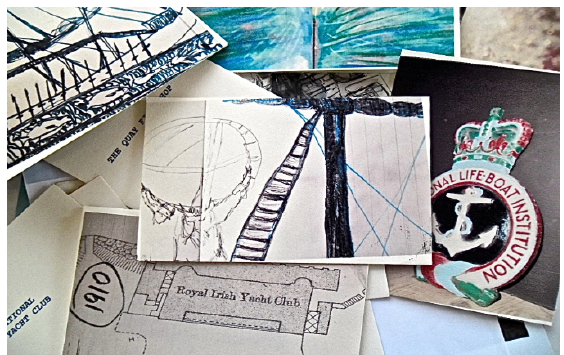
Figure 10. Glas Journal fragments, 2015. © Silvia Loeffler, Glas Journal,